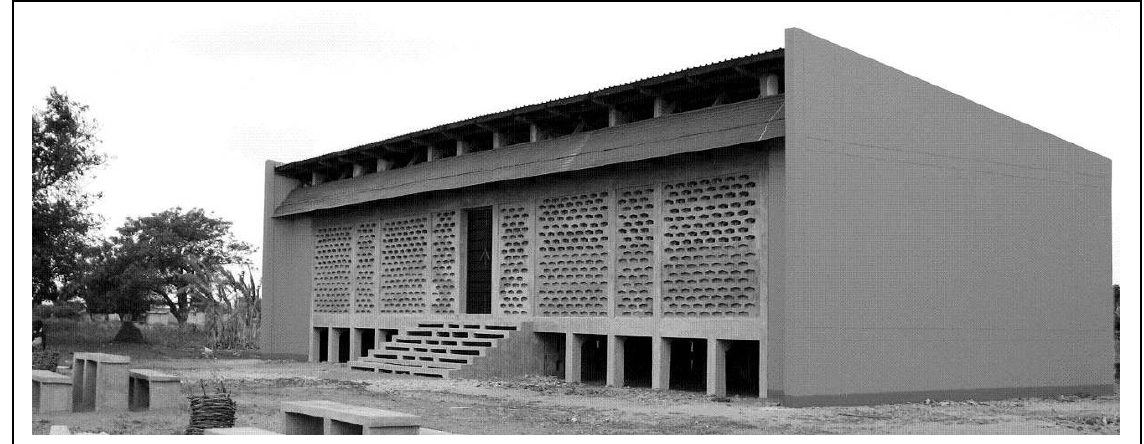
Figure 9. Elevated school of Maniquenique, Gaza Province, Mozambique.